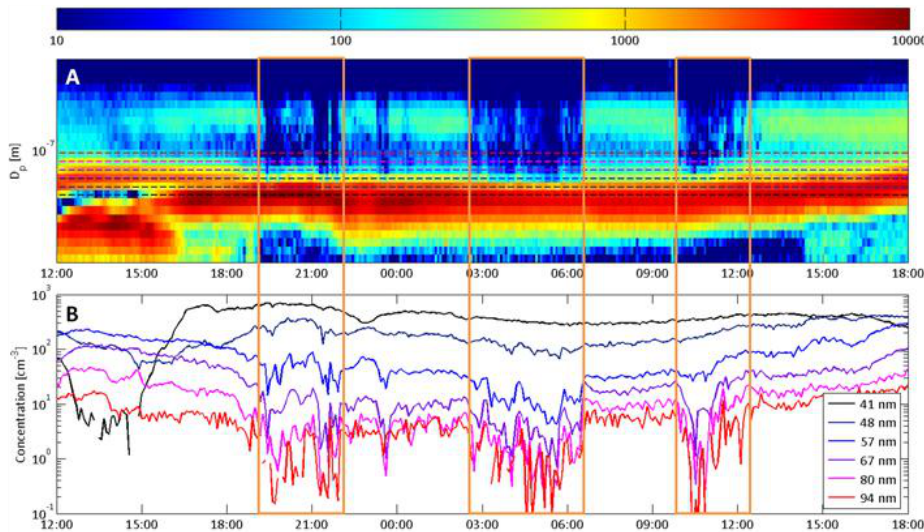
Fig. 15. Cloud droplet activation event during three cloud cover periods from 17 to 18 of January 2010. The times when the station was inside a cloud are denoted with orange boxes. The particle size distribution is shown in panel (A) , whereas the total concentrations for 41, 48, 57, 67, 80 and 94nm sized particles are shown in panel (B) . Same size bins are shown with correspondingly coloured dashed lines in the surface plot. No activation is seen in the smallest size bin, 41nm, but already some particles are activated in the next, 48nm size bin (see the first and second cloud cover period, where the small decreases in concentration of 48nm particles happen at the same time as in the larger sizes), and finally the activation is very clear in the 57nm sized particles.